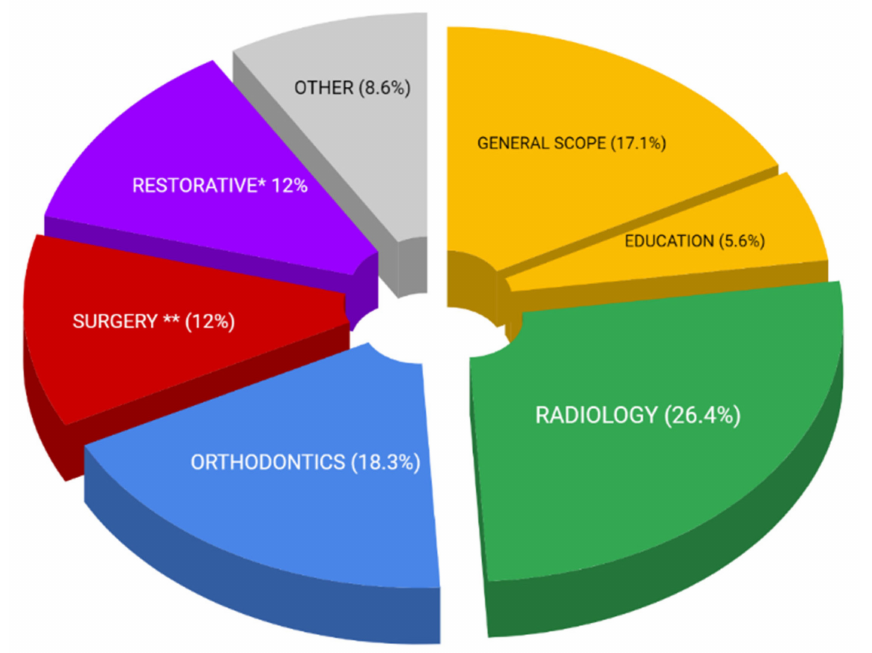
Figure 6. Simplified pie graph visualizing proportionality of current AI focus in dentistry (1 January 2021–19 April 2022), where the focus on implants and cancer treatment is covered by Surgery, and Restorative dentistry also covers Endodontics and Prosthodontics. * Restorative dentistry in this chart covers also Endodontics and Pediatric dentistry. ** Surgery represents also Cancer diagnostics and Dental implantology.